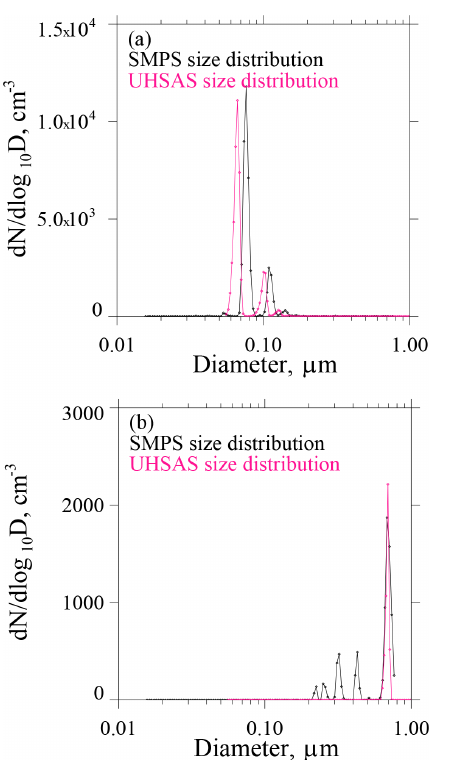
Figure A2. (a) ASDs corresponding to mobility-selected D = 0 . 075µm ammonium sulfate test particles. (b) ASDs correspond- ing to mobility-selected D = 0 . 71µm polystyrene test particles. Figure A3. (a) Size-integrated concentration from the UHSAS ver- sus concurrent laboratory measurements of concentration from the CPC. Results are for mobility-selected ammonium sulfate test par- ticles with D < 0 . 2µm. (b) As in (a) but for mobility-selected am- monium sulfate test particles with D > 0 . 2µm and for mobility- selected polystyrene latex test particles with D > 0 .